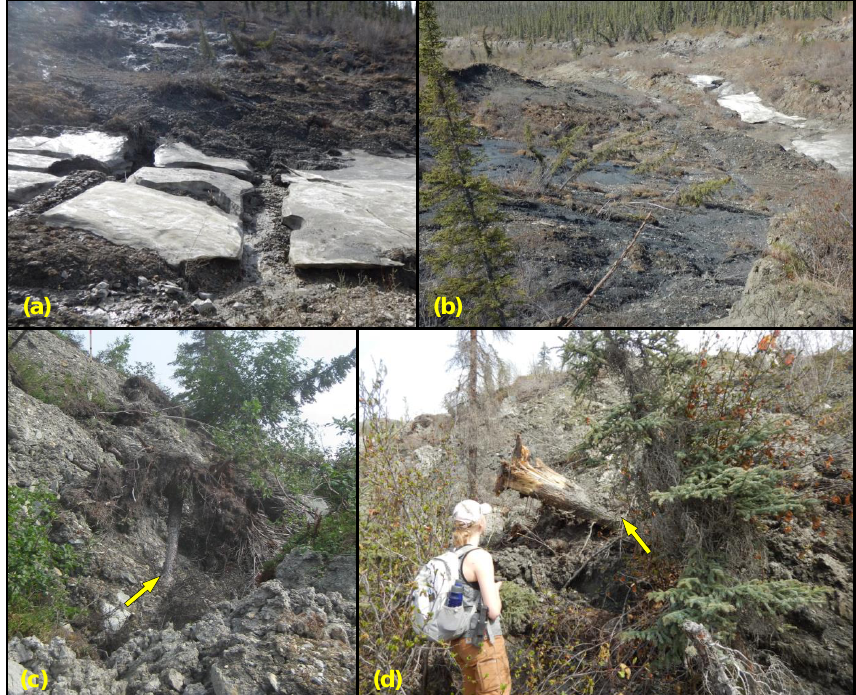
Figure 11. Destabilization of FDL-D. (a) Evidence of ongoing movement throughout the 2014–2015 winter and spring, as transverse cracks separate an aufeis deposit on the upper lobe. (b) View down the lobe from the head scarp of one of many RTSs in the catchment, looking over a debris flow originating from the exposed massive ice. (c) Tree completely upside down with root mass sticking out of a crack. (d) Trunk of tree sticking out of debris at toe of FDL-D. Yellow arrows in (c) and (d) point to the tree trunks exiting the lobe